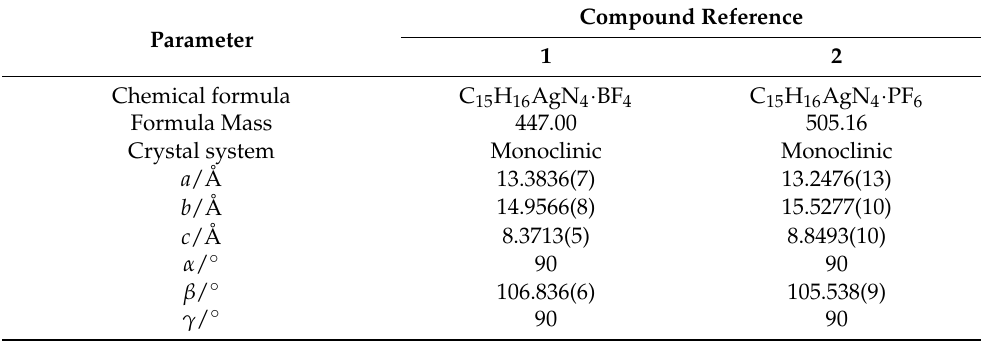
Table 1. Crystal data and details of the refinement parameters for the crystal structures 1 and 2 .